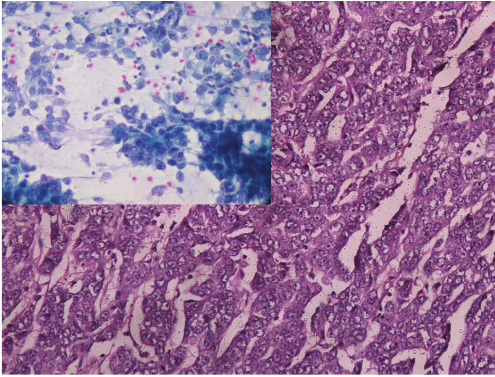
Figure 3: Infiltrating ductal carcinoma histological grade III—very minimal tubular differentiation, marked nuclear pleomorphism, coarse nuclear chromatin, prominent nucleoli, and brisk mitosis. Inset—highly pleomorphic tumor cells with marked nucleomegaly ( > 5 times the size of erythrocytes), irregular nuclear membrane, prominent nucleoli, and coarsely clumped chromatin (Robinson’s cytological grade III) (H&E, × 200; inset: PAP, × 400).